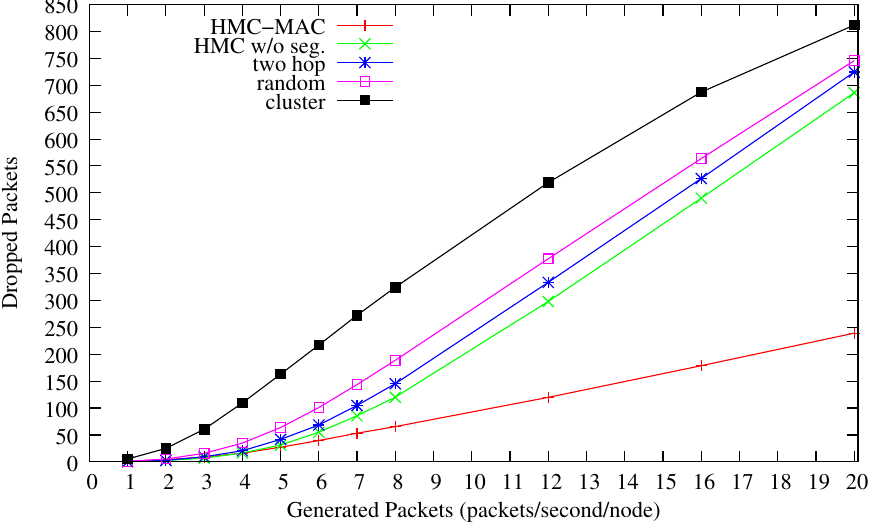
Figure 15. Number of dropped packets for periodic